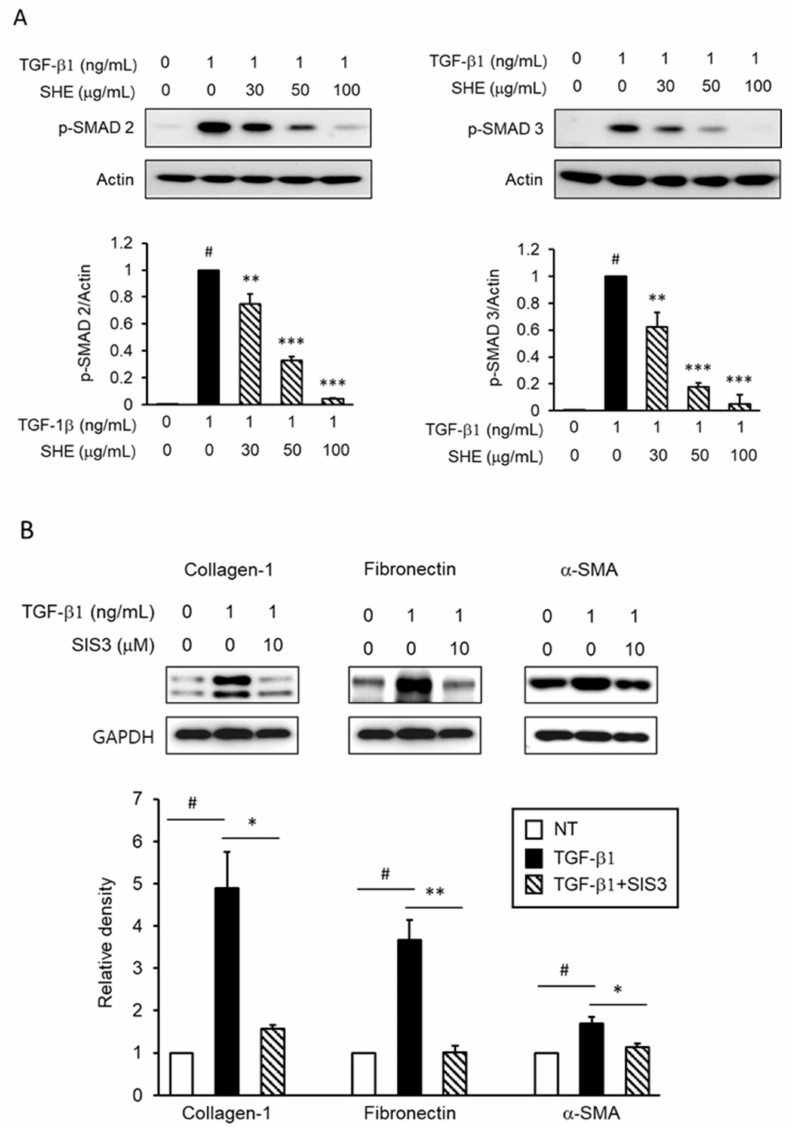
Figure 3. Effect of SHE on Smad 2/3 phosphorylation in TGF- β 1-induced NPDFs. ( A ) The cells were treated with the indicated SHE concentrations (30, 50, and 100 µ g/mL) for 1 h before stimulation with TGF- β 1 (1 ng/mL) for 1 h. Nuclear protein extracts were then prepared and subjected to western blotting with antibodies specific for the phosphorylated forms of Smad 2 and Smad 3. The results presented are representative of three independent experiments; ( B ) The NPDFs were treated with 10 mM of Smad 3 specific inhibitor (SIS3) for 1 h, prior to stimulation with TGF- β 1 (1 ng/mL) for 24 h. Each bar represents the mean ± SEM ( n = 3) from three independent experiments. # p < 0.05 vs. control group (no treatment group); * p < 0.05, ** p < 0.01, and *** p < 0.001 vs. TGF- β 1-stimulated